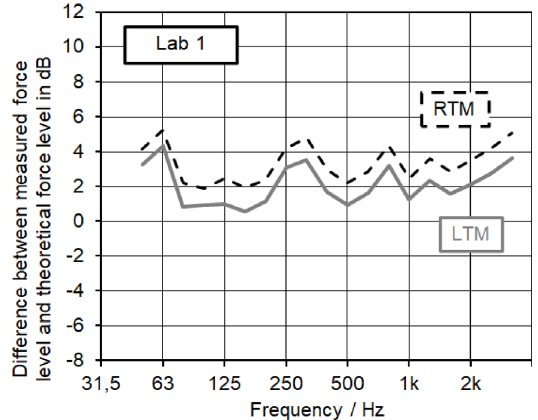
Figure 11. Difference between measured level of equivalent blocked force and theoretical value with T = 0.5 s and ffiffiffi p (cid:7) (cid:8) v 0 ¼ (cid:3) 1 v 2 for RTM and LTM in lab 1. max max